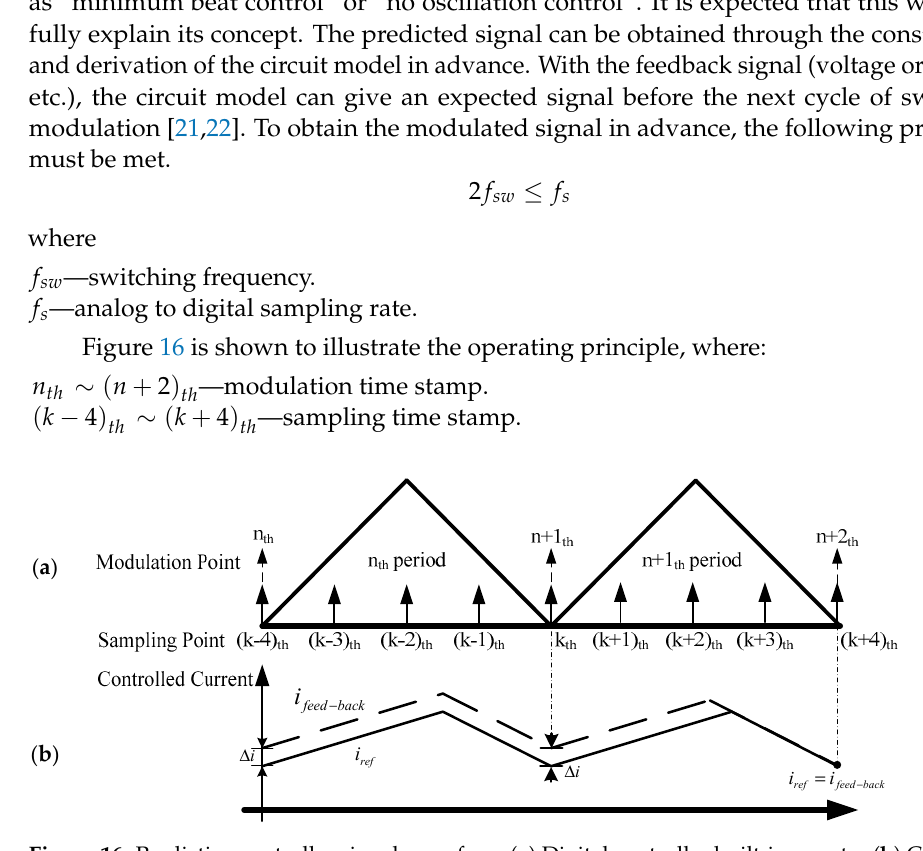
Figure 17. Circuit diagram of voltage–current relationship of the filtering inductor. (cid:1874) (cid:3013) = (cid:1838)(cid:1856)(cid:1861) (cid:3013) (cid:1856)(cid:1872)